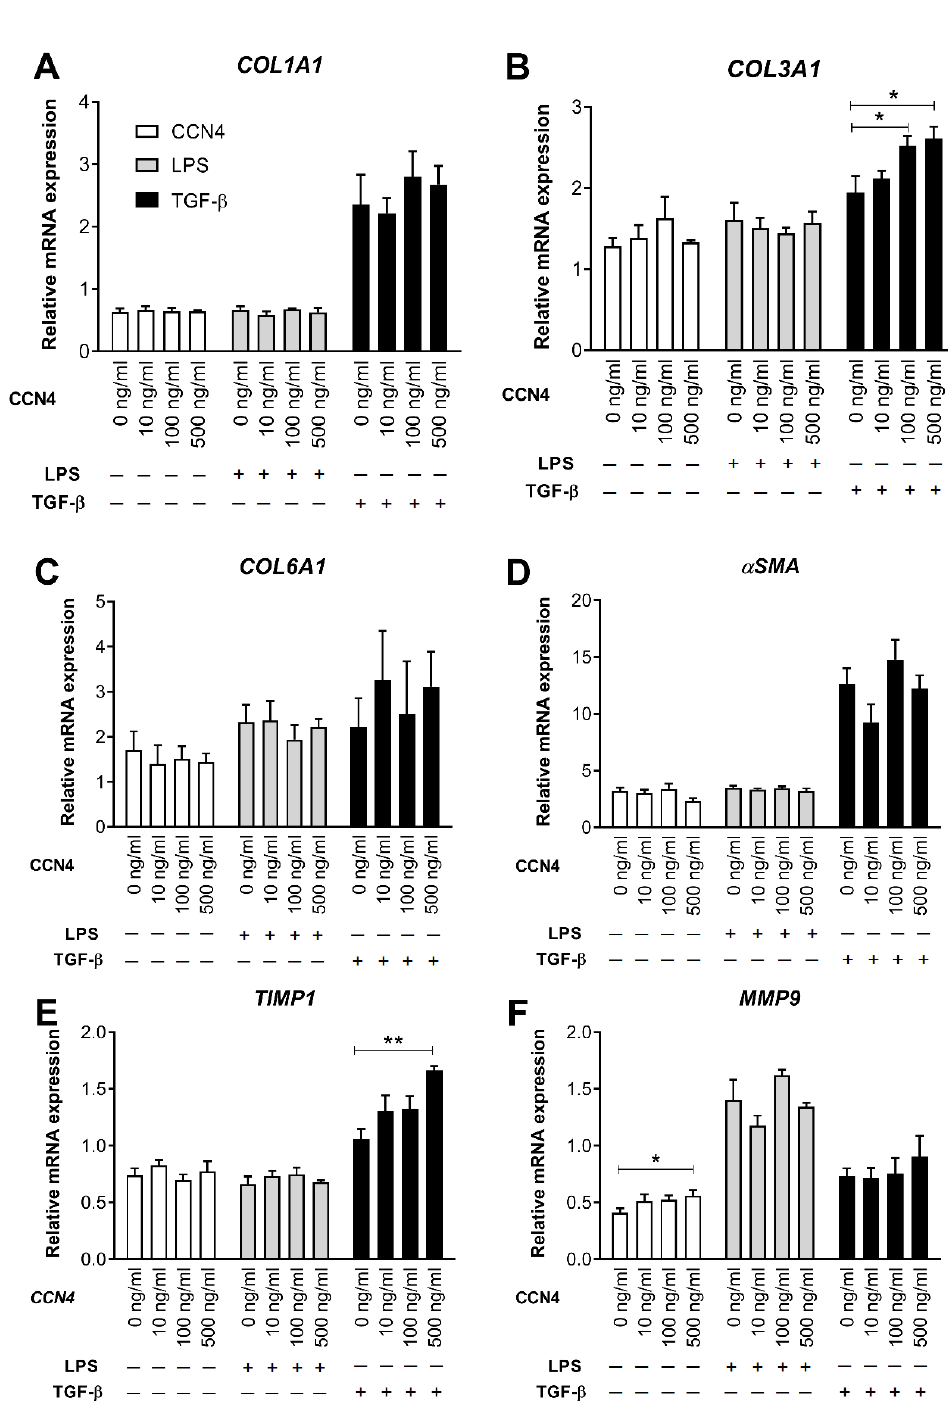
Figure 2. CCN4 effects on fibrosis marker expression in hepatic stellate LX-2 cells. LX-2 cells were stimulated for 24 h with human recombinant CCN4 (0, 10, 100 or 500 ng/mL; in white) alone or in combination with 1 ng/mL LPS (grey bars) or 1 ng/mL TGF-β (black bars), and the mRNA expression of COL1A1 ( A ), COL3A1 ( B ), COL6A1 ( C ), α SMA ( D ), TIMP1 ( E ), and MMP9 ( F ) was measured by qPCR ( n = 4). Data are shown as mean ± SEM. * p < 0.05, ** p < 0.01.